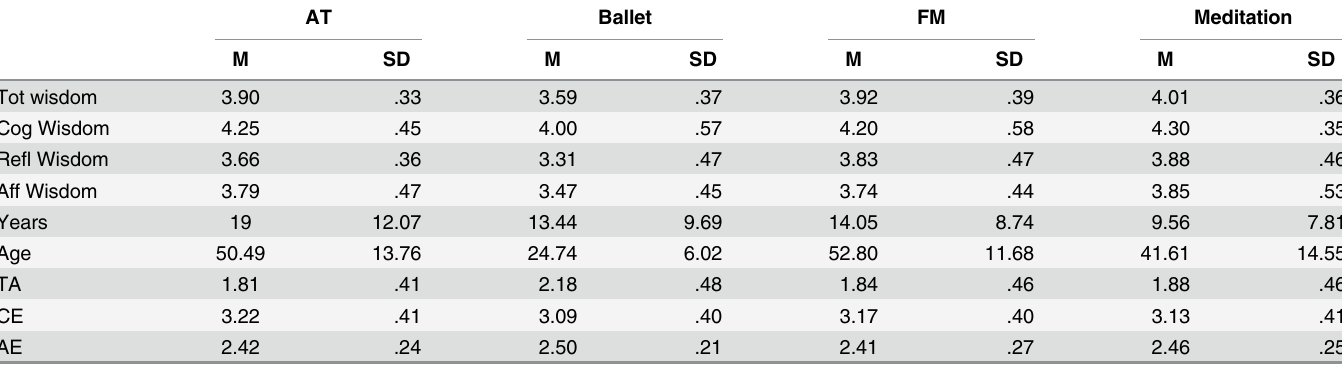
Table 1. Means and standard deviations of wisdom, its components, and predictor